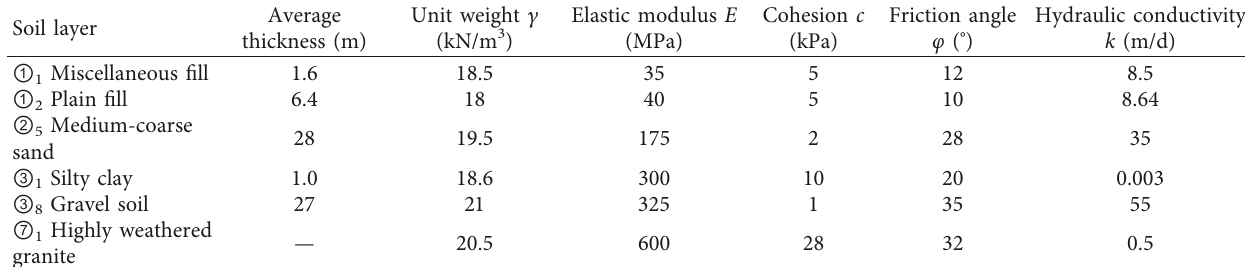
Figure 5: Hydromechanical numerical model. Table 1: Physicomechanical properties of soils at study